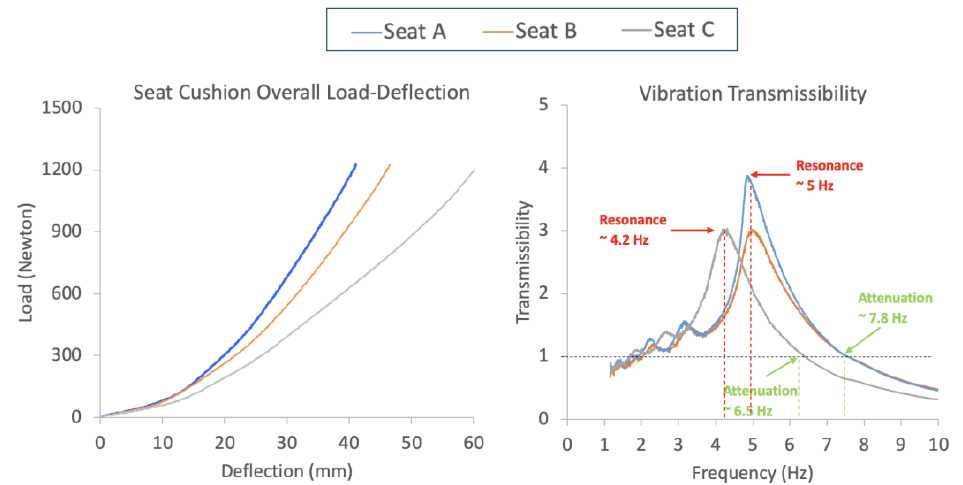
Figure 2. Overall hardness measured by load-deflection curves ( left ) and vibration transmissibility ( right ) of three testing seats per SAE J2896.